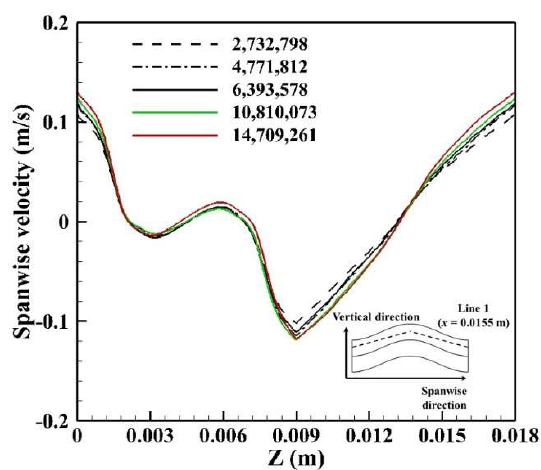
Figure 4. Grid independence test results.